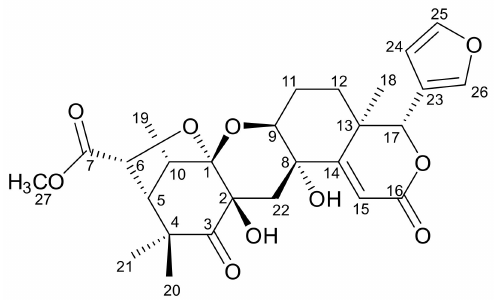
Figure 1. Chemical Structure of Compound 1